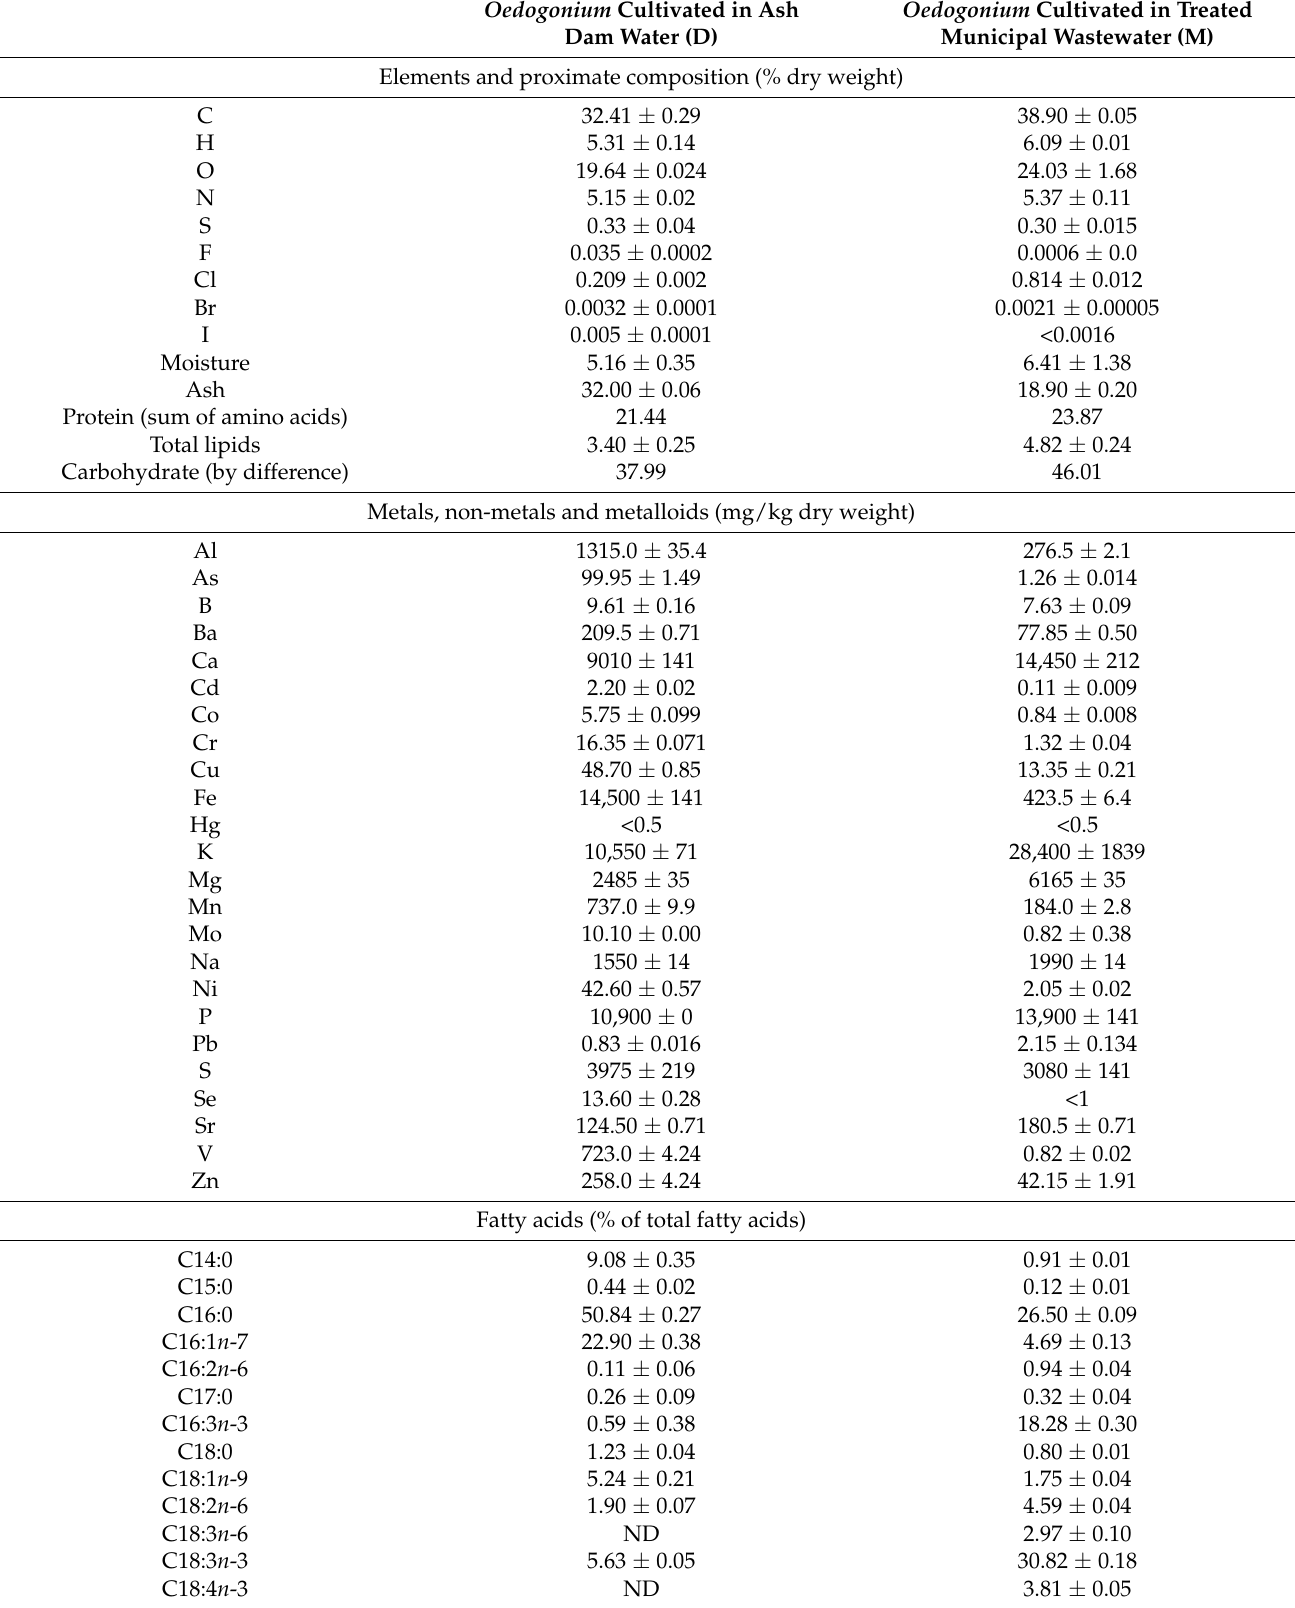
Table 1. Elemental and macronutrient composition of macroalgae. Oedogonium Cultivated in